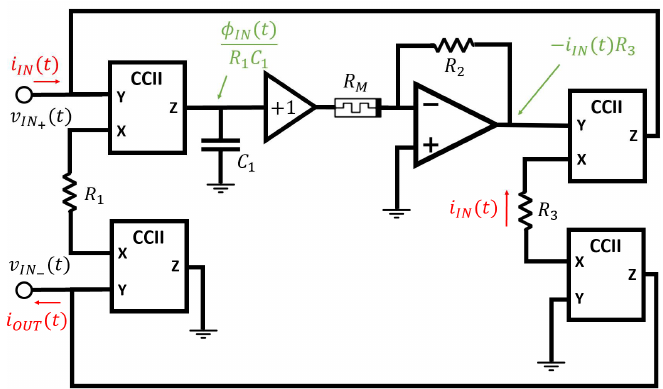
Figure 14. Floating meminductor emulator circuit based on current conveyors proposed by Liang et al . [36] .